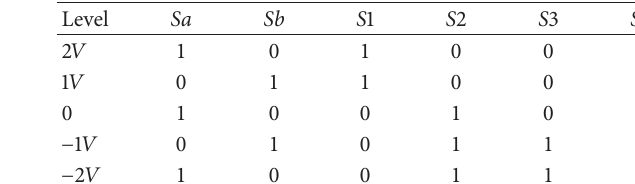
Table 1: Switching states for five-level